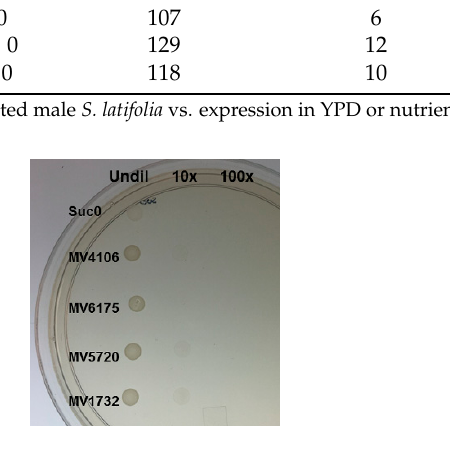
Figure 2. Results of secretion trap experiment with four M. lychnidis-dioicae predicted small secreted proteins (SSP) effectors. Suc0, yeast cells transformed with vector alone on sucrose, leu drop-out medium. Undil, undiluted; 10× and 100× dilutions. Table 1. Candidate SSPs chosen for further analyses.